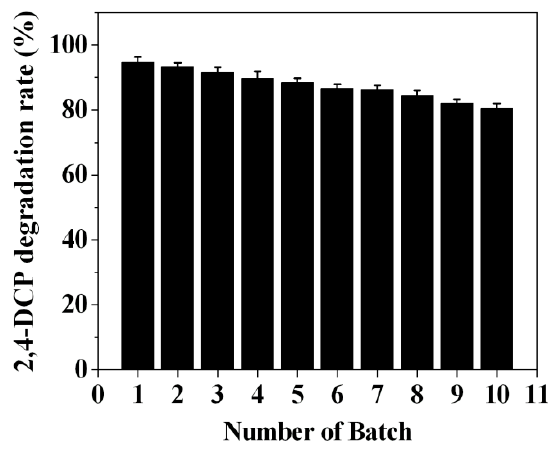
Figure 6. Reusability of entrapped laccase.